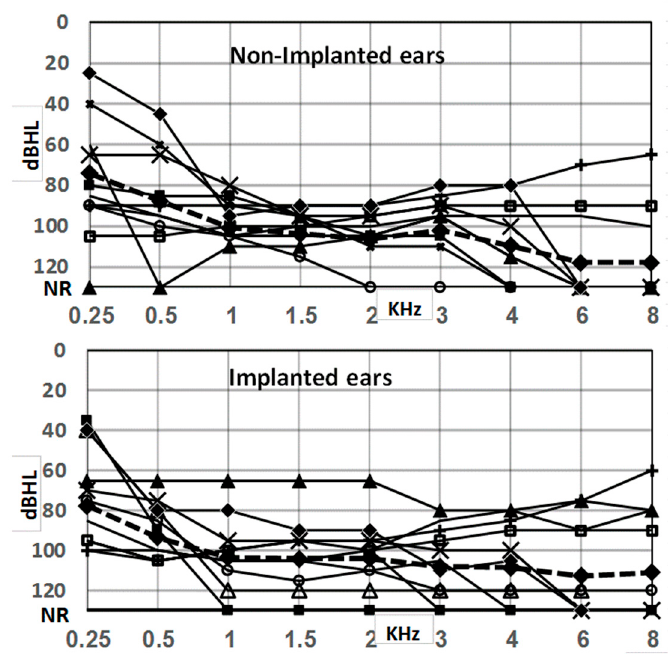
Figure 1. Preoperative air conduction audiograms of 13 of 17 study participants of the SNHL groups for whom an audiogram was available. Bone-conduction thresholds were not measurable for most of the participants; in two subjects, there were measurements in the 250–500 Hz range, but those showed no presence of ABGs. No significant differences in thresholds were found between implanted and non-implanted